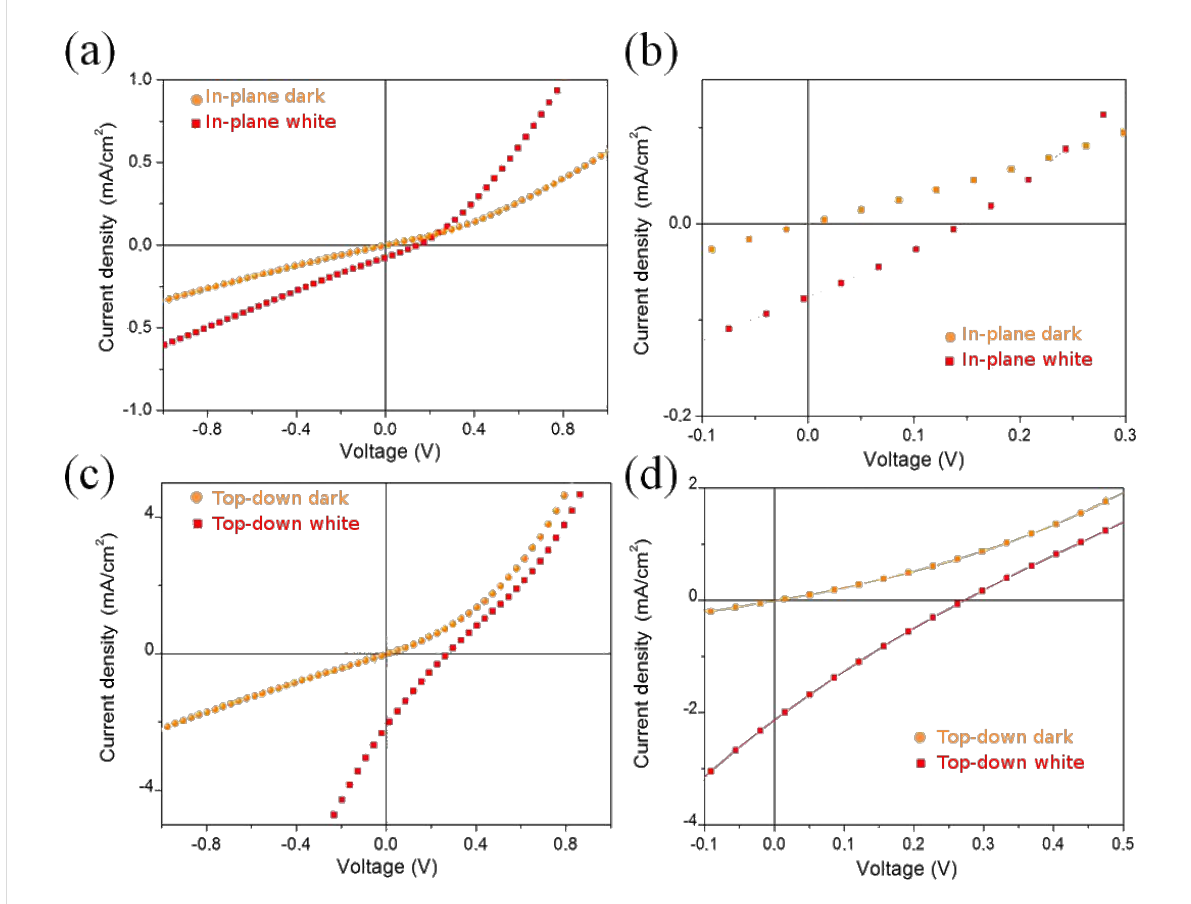
Figure 10: J – V characteristics acquired in the dark and under illumination by white light. (a) In the in-plane geometry: V oc = 0.2 V, J sc = 0.09 mA/cm 2 . In the third and fourth quadrant the J – V curve is almost linear. This could be due to the presence of parasitic resistances, which lower the perform- ance of the device. An inhomogeneous MWCNT film, in which all the MWCNTs are not in good contact with each other, could be the cause of such a high resistance. (b) Detail of (a) in the most meaningful zone, i.e., in the fourth quadrant of the J – V characteristic. (c) Top-down geometry: V oc = 0.25 V, J sc = 2.2 mA/cm 2 . Under illumination, the J – V curve line shape exhibits the behaviour of a double diode: beyond the MWCNT–Si Schottky junction, the second one is formed at the back contact between Si and Al, i.e., a hint of a non-ohmic contact. (d) Detail of (c) in the most meaningful zone, i.e., in the fourth quadrant of the J – V